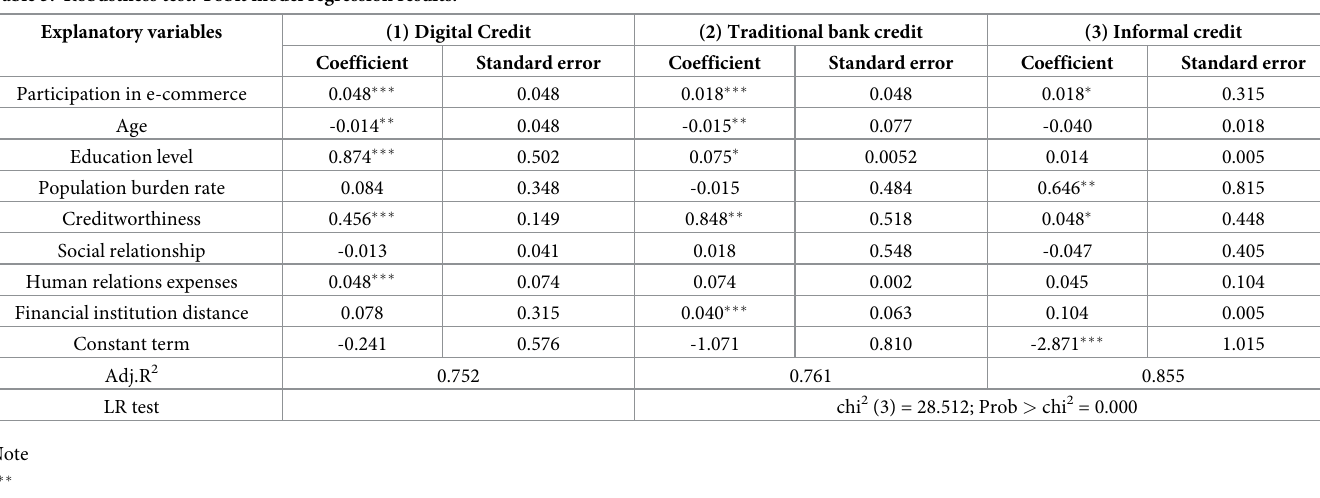
Table 5. Robustness test: Tobit model regression results.